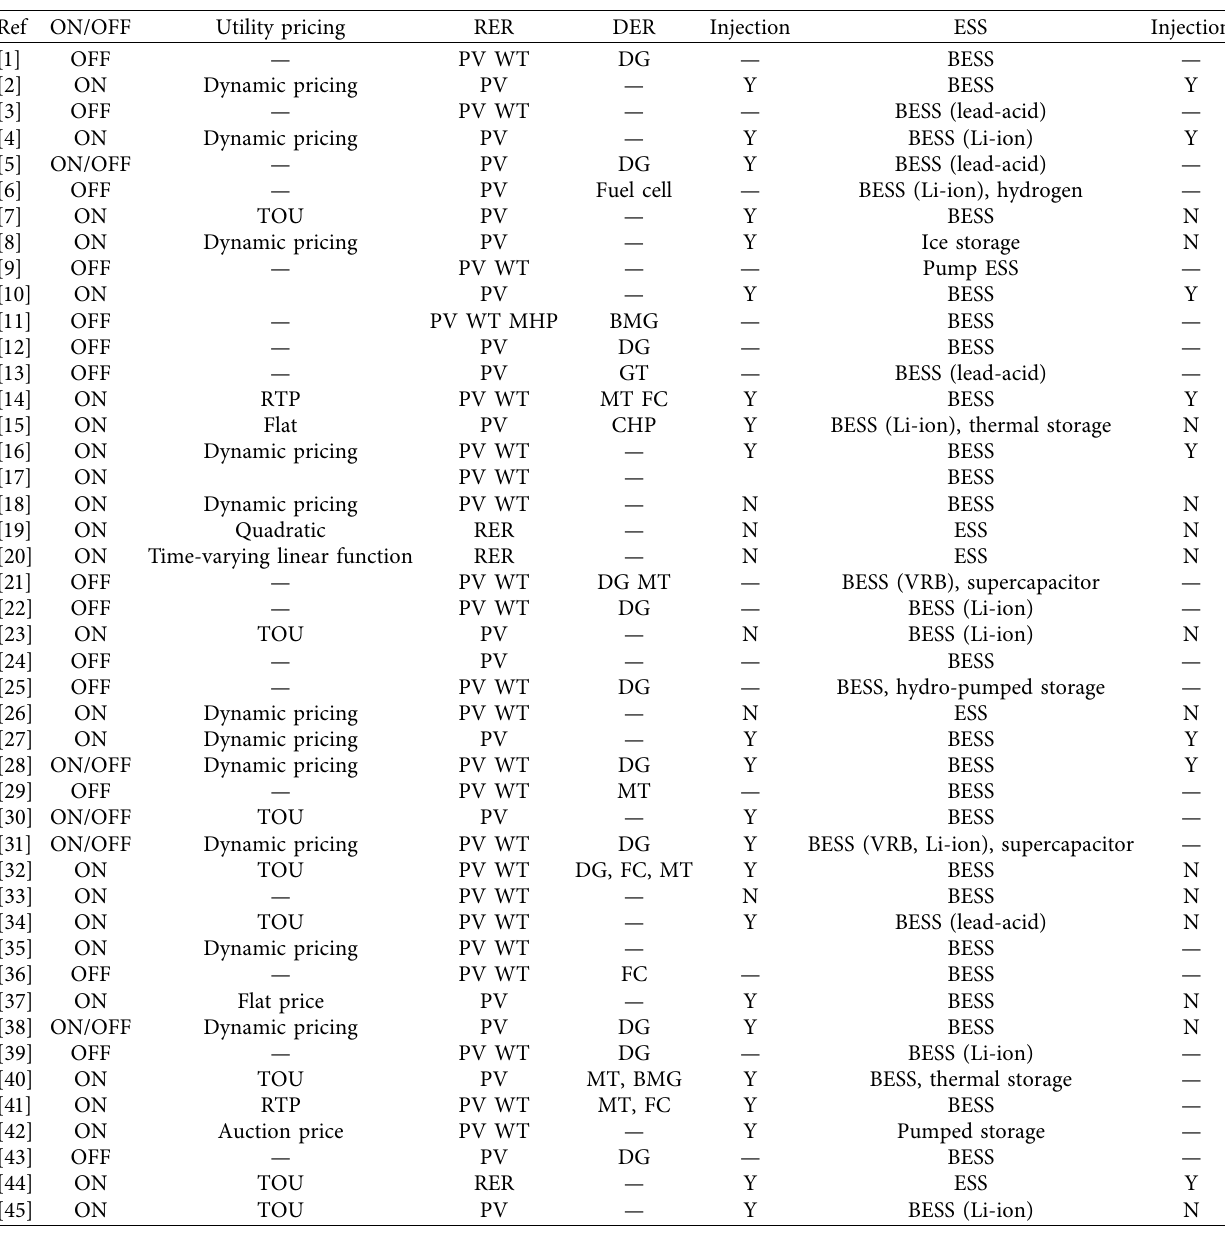
Table 4: Suggested